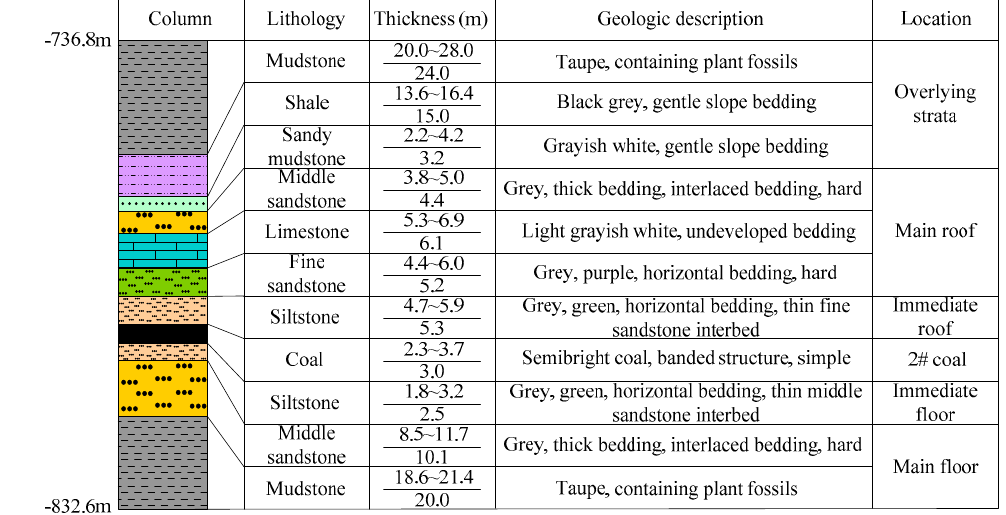
Figure 1. Layout of mine location and 2415 working face.